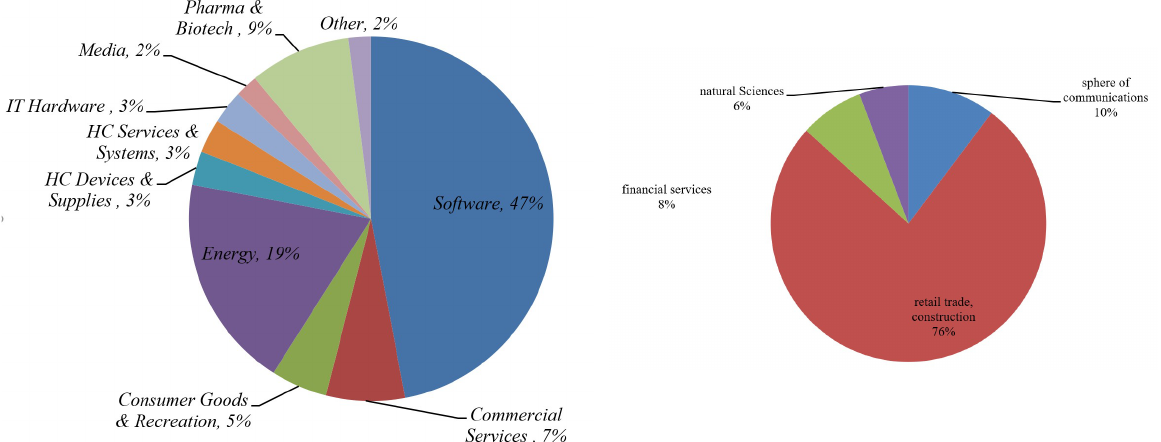
Fig. 1. The structure of venture capital in the global financing of innovative industries of the European Union countries, 2017